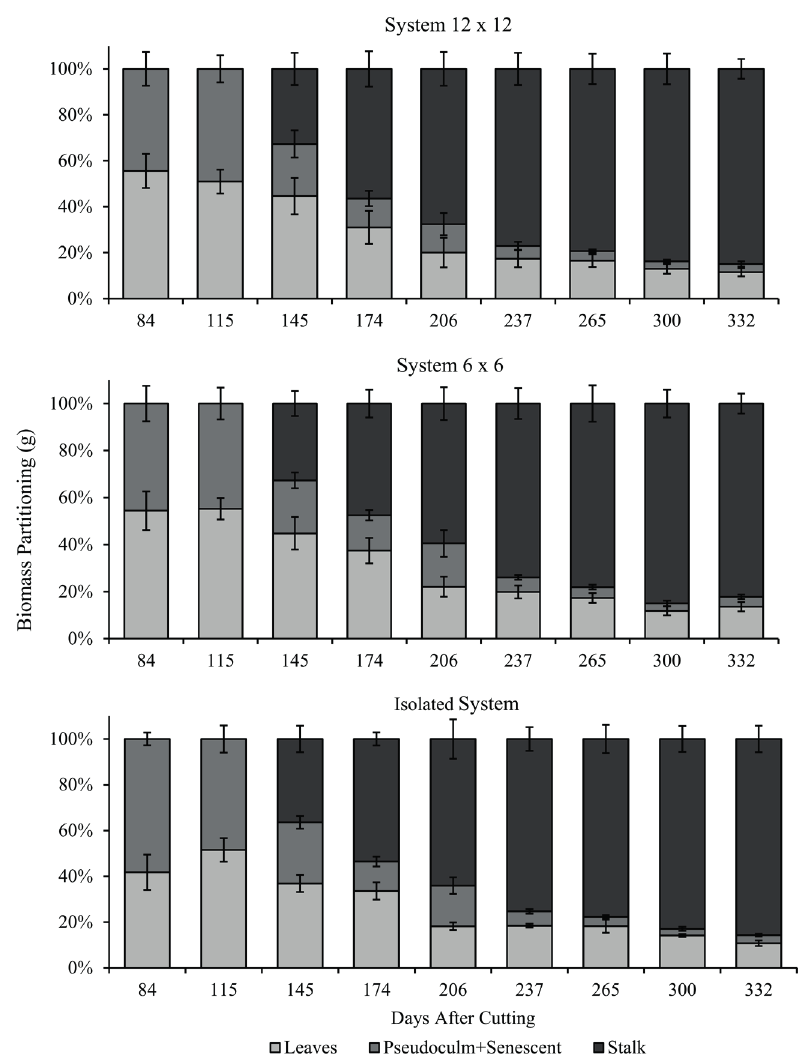
Figure 7 - Biomass partitioning in sugarcane plants in different cropping systems throughout the days after cutting. Each bar represents the mean value of twelve replications (±